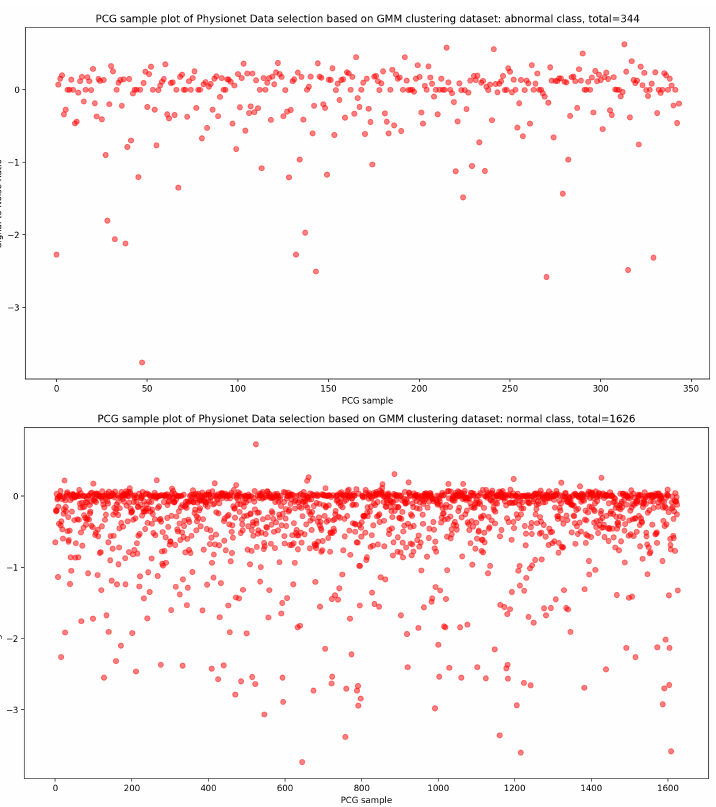
Figure 14. An overview of KDE curve in function of SNR for normal and abnormal PCG classes after GMM data selection process.